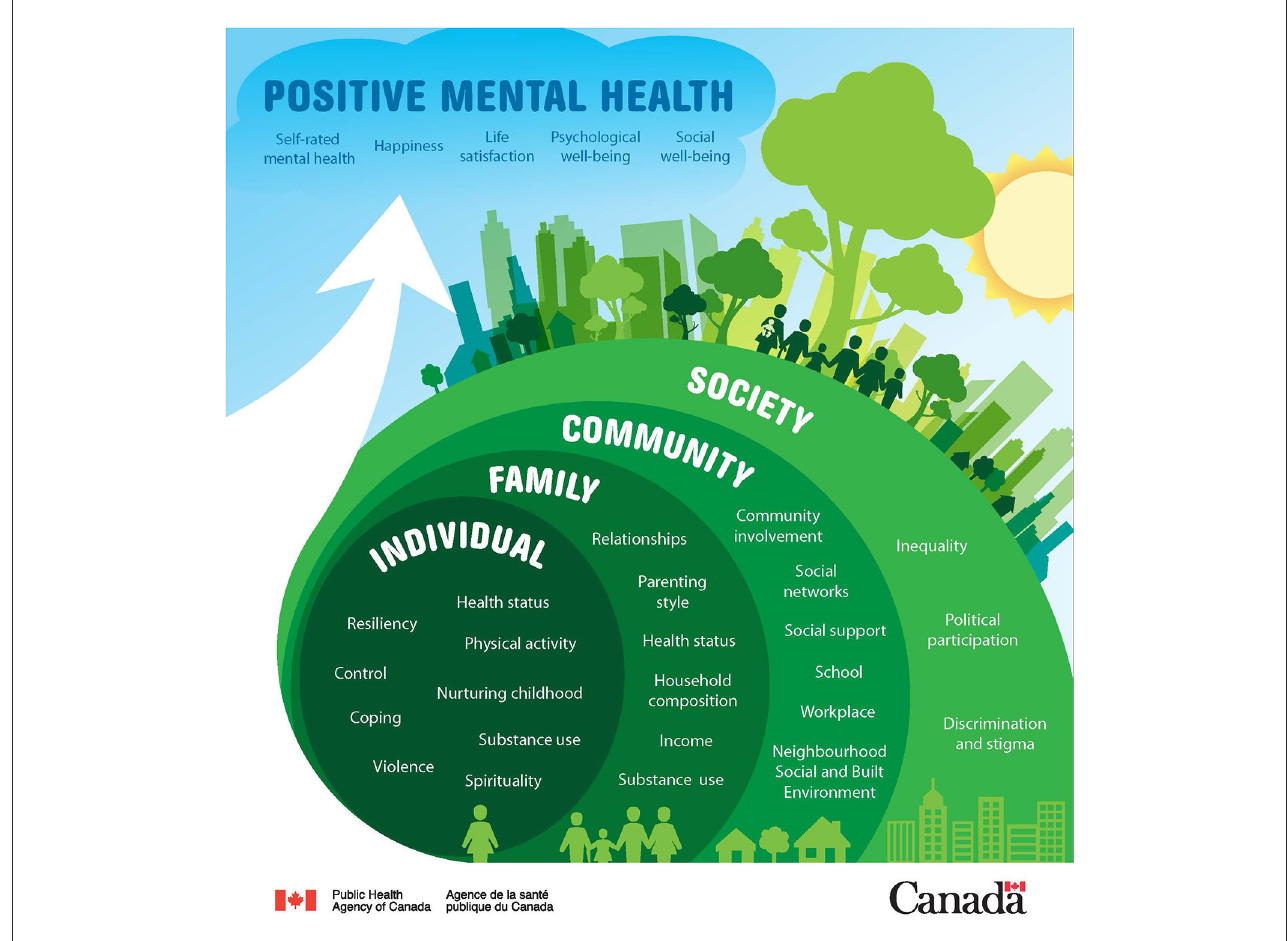
FIGURE1 Positive mental health conceptual framework for surveillance. Developed by Orpana et al.